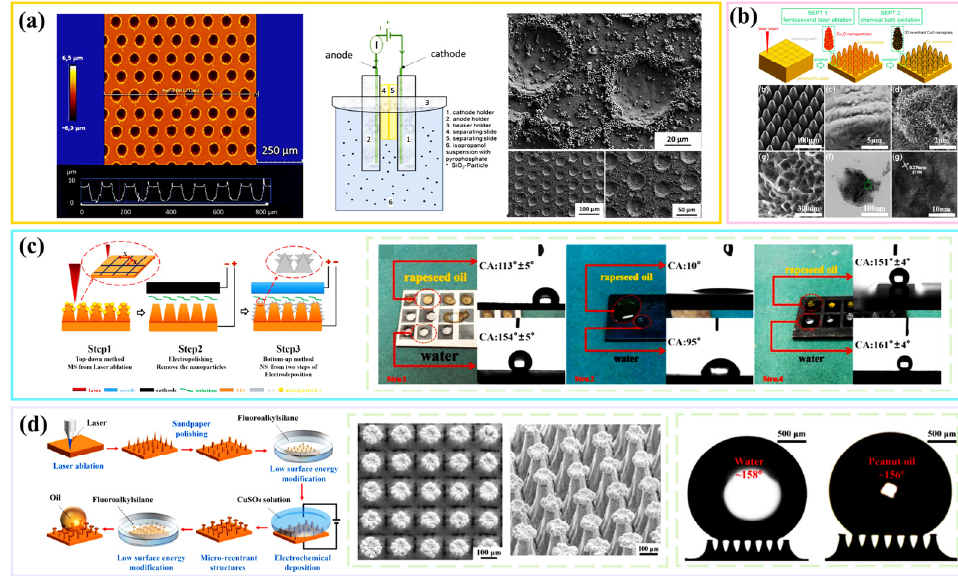
Figure 11. Preparation of superamphiphobic surface by laser and its hybrid methods: ( a ) Laser texturing of aluminum alloy surface and deposition of SiO 2 micro-spheres [122], ( b ) Laser-chemical bath deposition [123], ( c ) Laser-electrochemical hybrid fabrication [98], ( d ) Laser-electrochemical hybrid fabrication of roof structures [120].